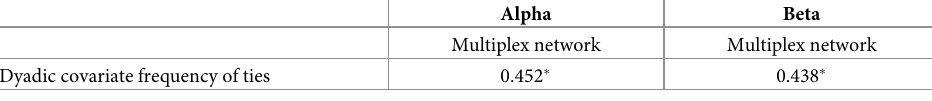
Table 5. Alpha and beta communities Pearson correlation between multiplexity and strength of ties